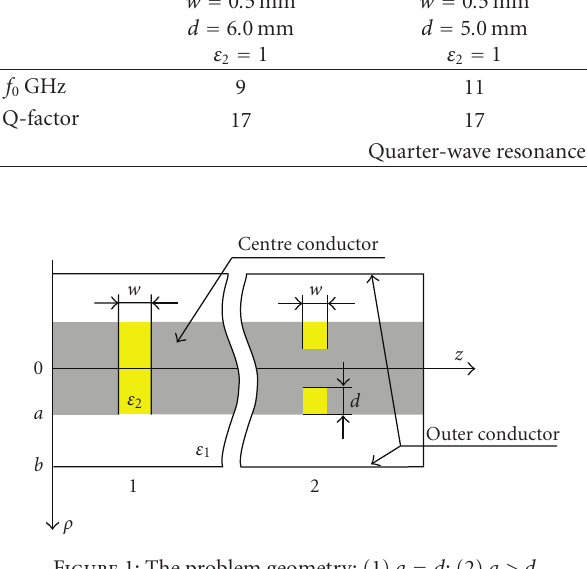
Figure 1: The problem geometry: (1) a = d ; (2) a > d .